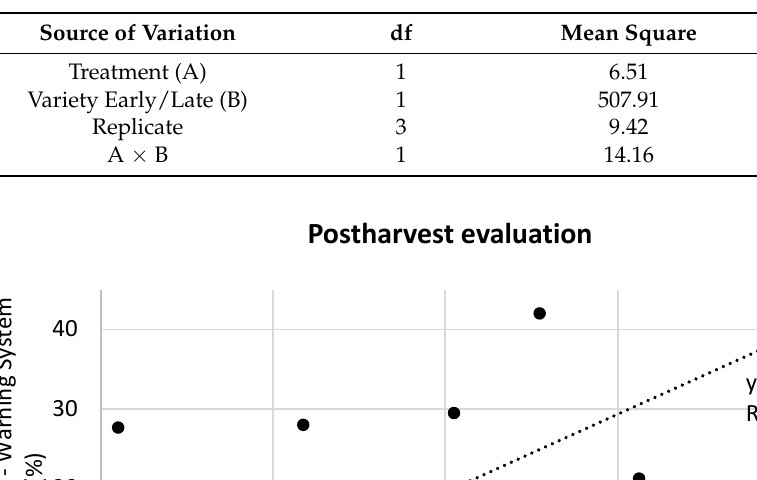
Table 3. Summary of analysis of variance of brown rot incidence recorded in postharvest at harvest time among 38 trials conducted during 6 seasons (2012–2017).